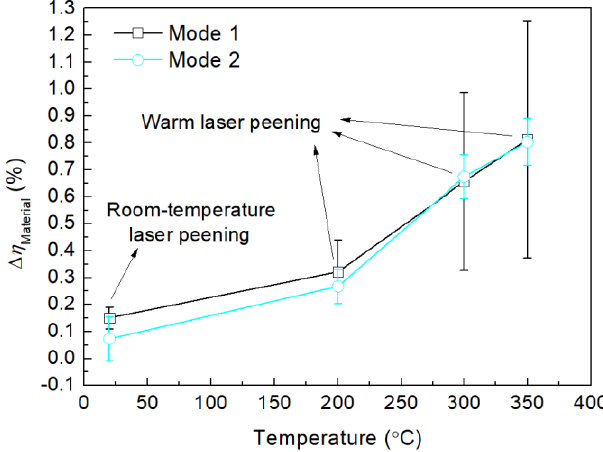
∆ η Figure 7. The value of Δ η material as a function of laser shock peening temperatures. Figure 7. The value of material as a function of laser shock peening